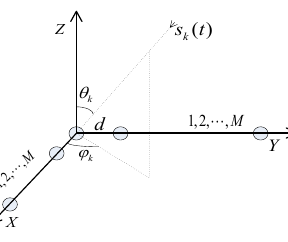
Fig. 1. L-shaped array with 2M − 1